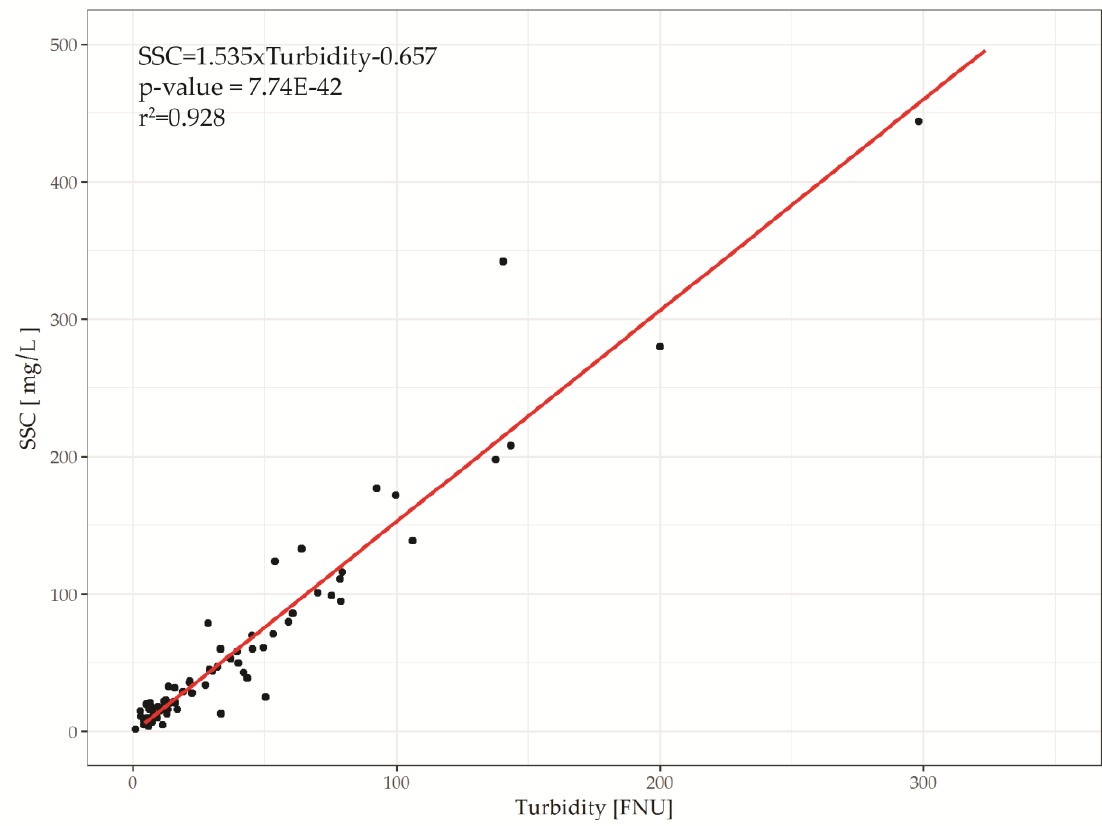
Figure 3. Scatter plot of the relationship between the suspended-sediment concentration (SSC) (mg/L) and the turbidity (formazinnephelometricunits, FNU).